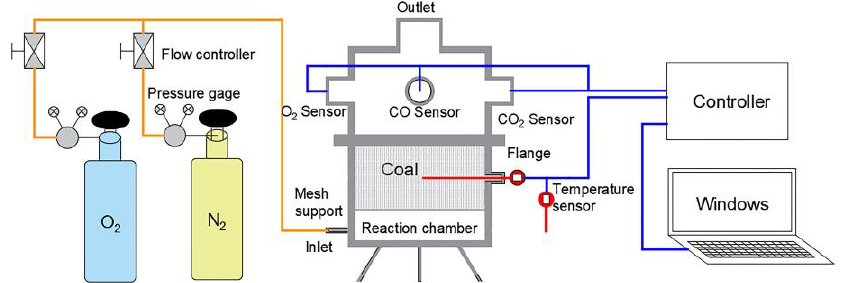
Figure 2. Ambient temperature oxidation device.